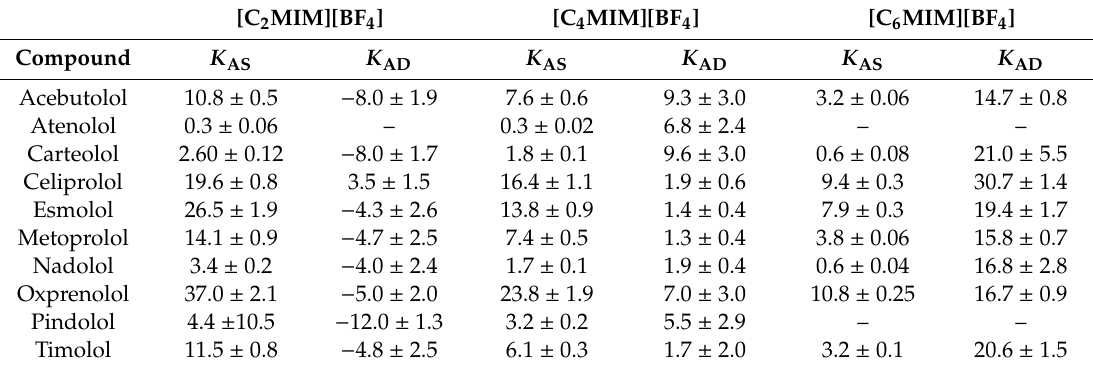
Table 3. Association constants between the solute and stationary phase ( K AS ) and between the solute and additive in the mobile phase ( K AD ) in the presence of tetrafluoroborate